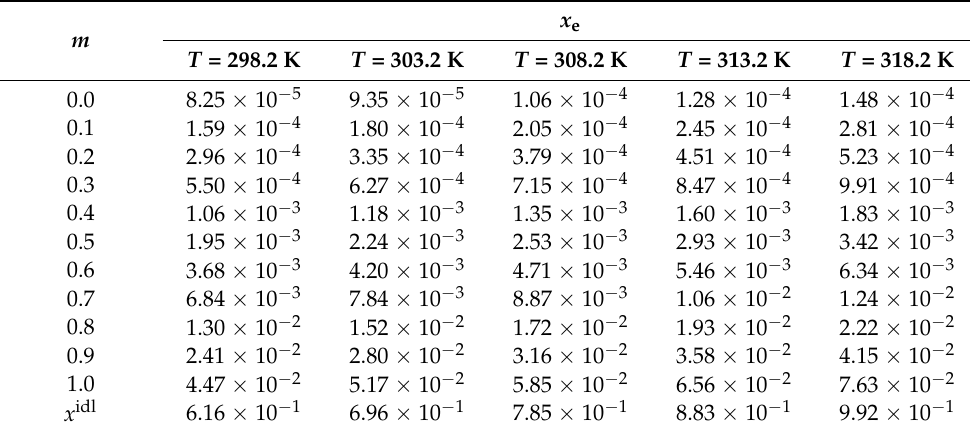
Table 1. Experimental solubilities ( x e ) of thymoquinone (TQ) in mole fraction in various isopropyl alcohol (IPA) + water (H 2 O) mixtures at 298.2–318.2 K and 0.1 MPa a . m